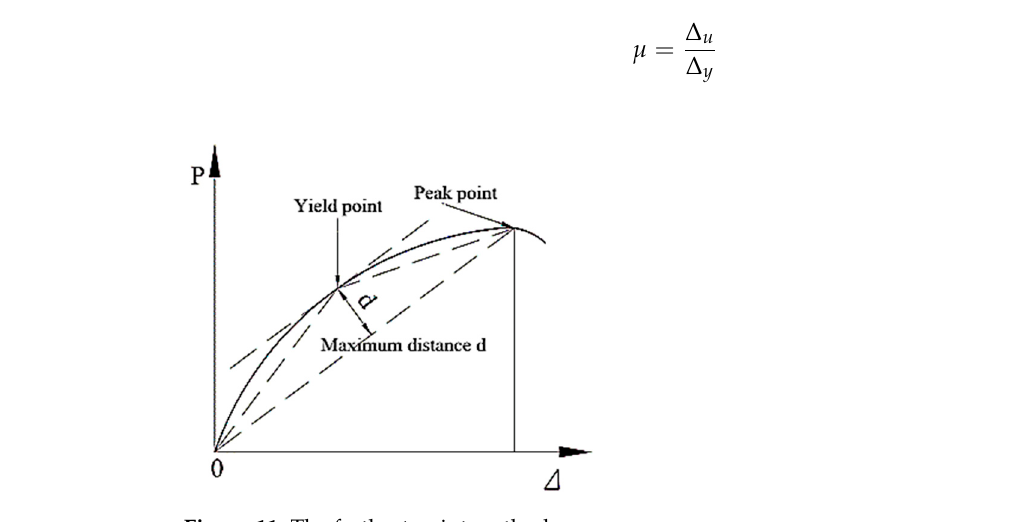
Table 4. Displacement ductility factors of specimens.